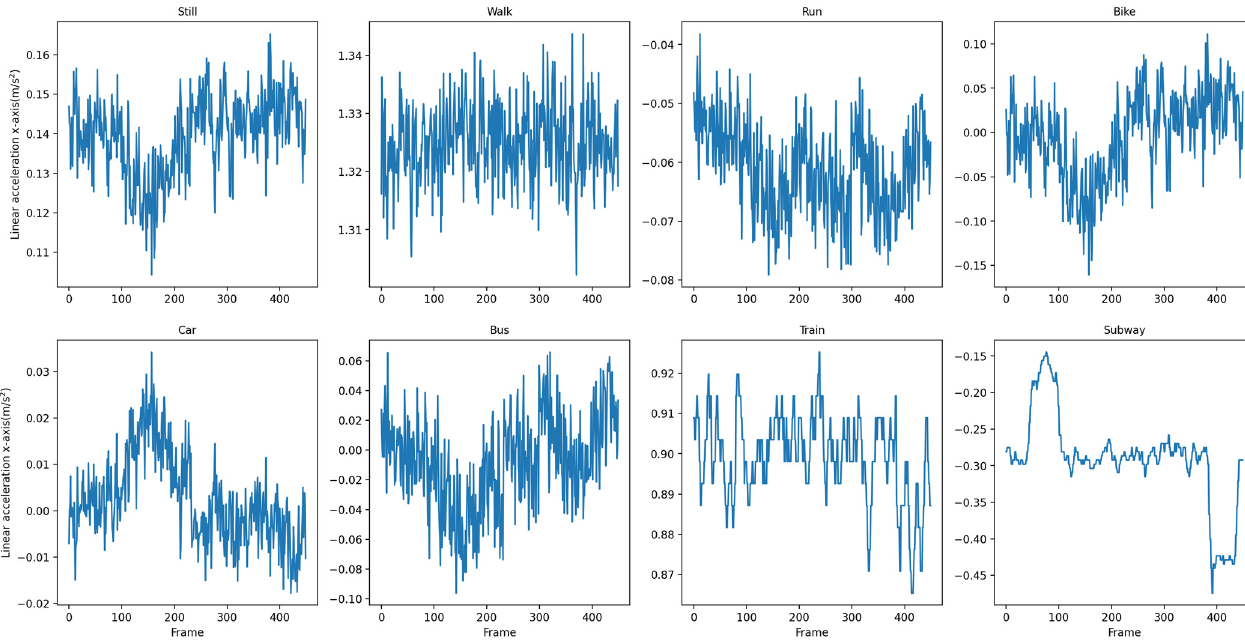
Figure 6. Data on the x-axis of the linear acceleration in 8 traffic modes in the SHL dataset.